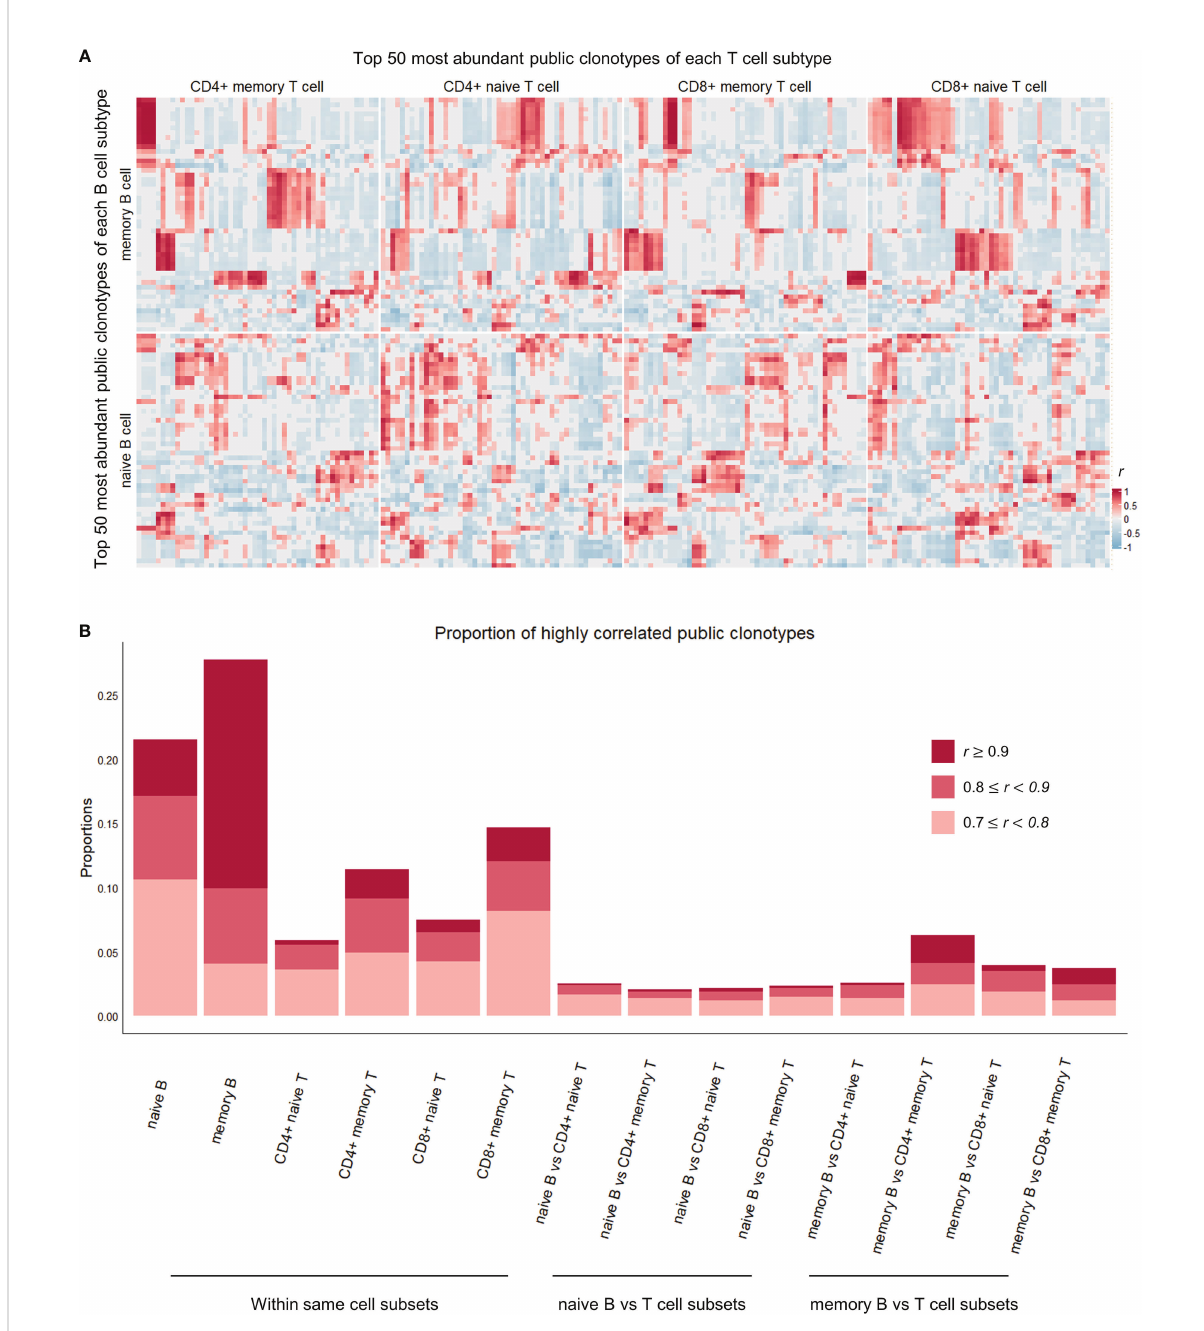
FIGURE 3 Correlation heatmap of top 50 most abundant public clonotypes and proportions of highly correlated clonotypes in each cell subtype comparison category. (A) Heatmap showing correlation coef fi cients r between the proportions of the top 50 most abundant B (vertical axis) and T (horizontal axis) public clonotypes of each naïve B, memory B, CD4+ naïve T, CD4+ memory T, CD8+ naïve T, CD8+ memory T cell subsets. The individual clonotypes have been hierarchically clustered based on the correlation coef fi cients within their respective cell subset comparison categories. The correlations between public clonotypes of memory B and memory T cells, in upper left square, are most pronounced and most clearly clustered, whereas correlations between naïve B cell public clonotypes and T cell public clonotypes from various T cell subsets are less pronounced. (B) Stacked boxplot showing the proportions of highly ( r > 0.7) and signi fi cantly ( P -value< 0.05) correlated public clonotypes within the same cell subsets (on the left), and between different B and T cell subsets (on the